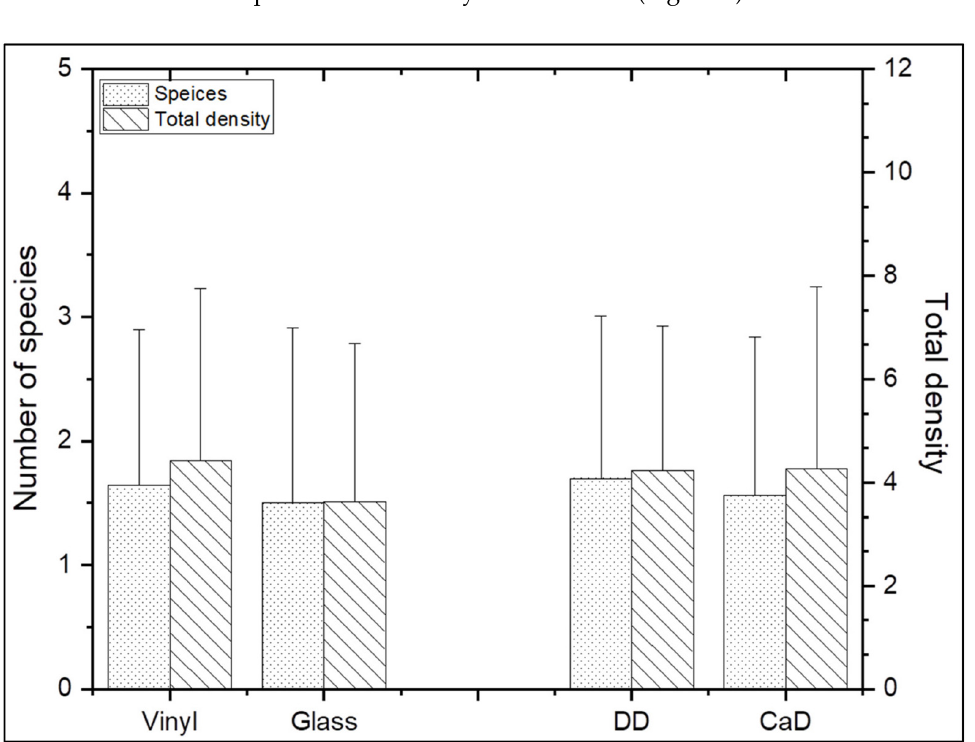
Figure 7. Average density of bacteria detected according to the type of greenhouse and drainage. Vinyl: vinyl greenhouse, Glass: glass greenhouse, DD: direct discharge, CaD: collection after